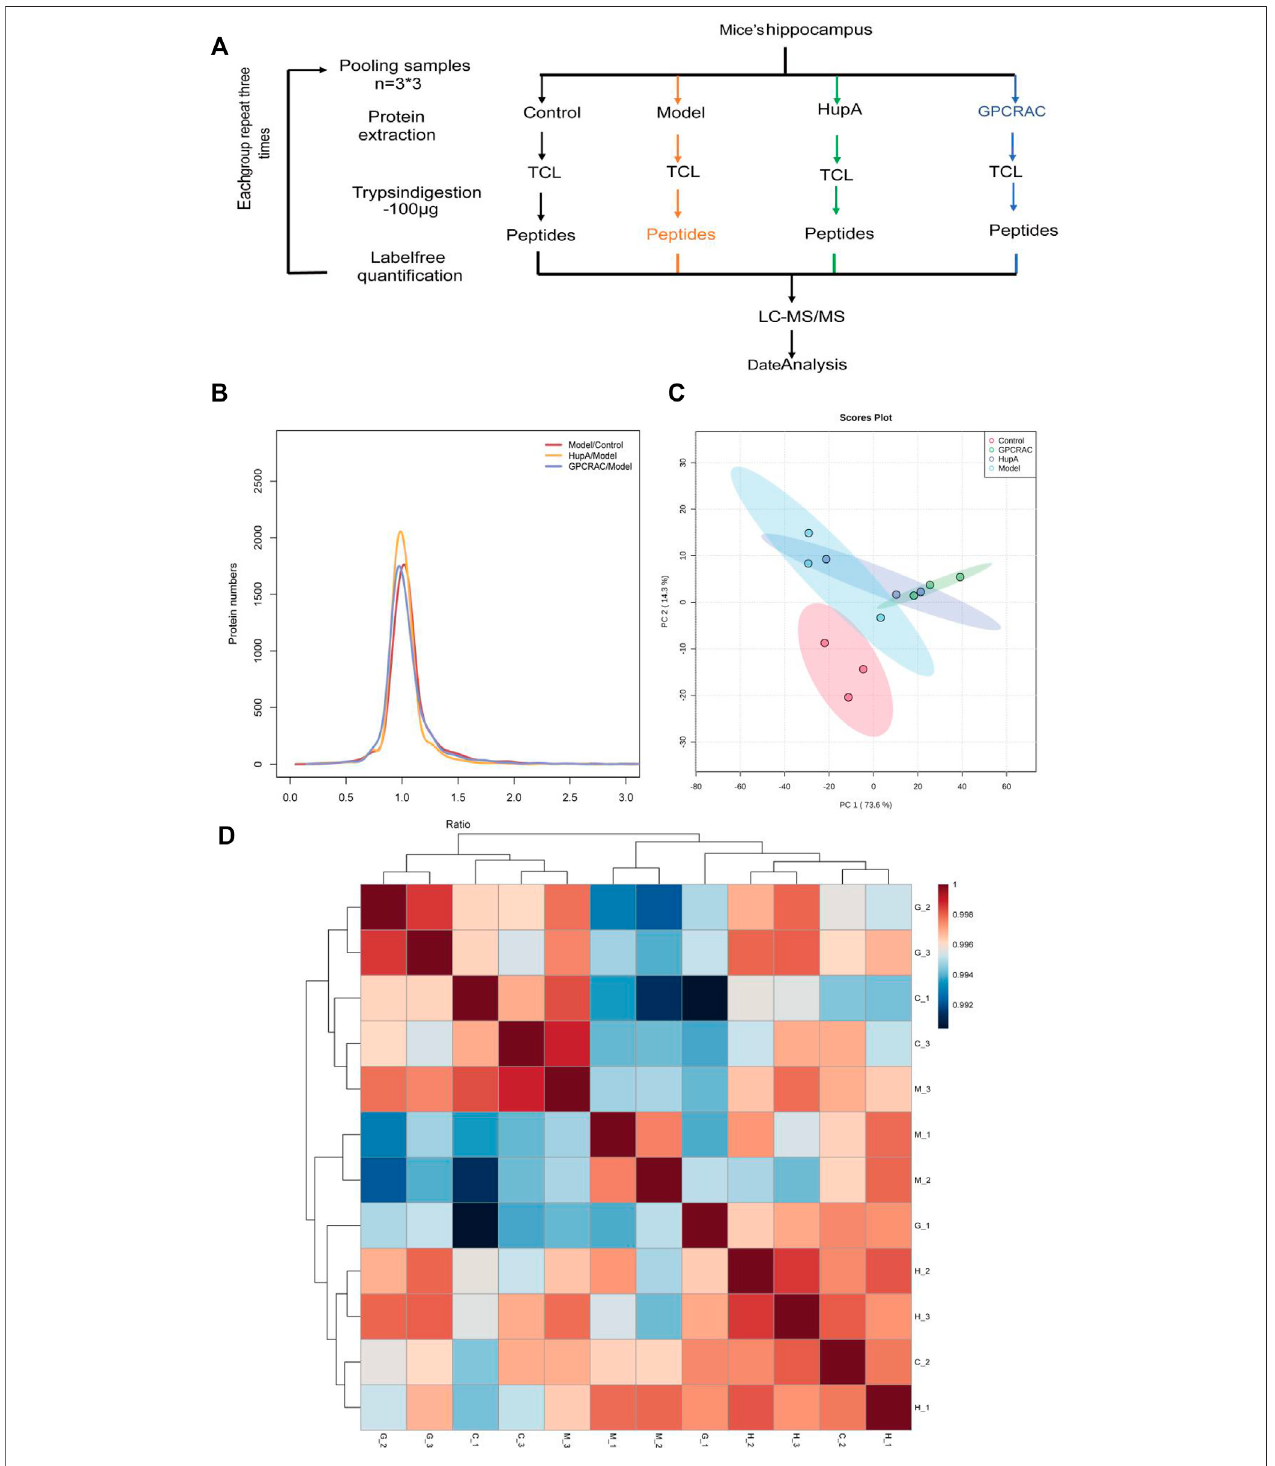
FIGURE 4 | Quality assessment of the proteomic data. Graphical illustration of the work fl ow used for our LC-MS/MS-based proteomic analysis (A) ; Log2ratio distribution of all differentially expression proteins detected in each group of three replicate samples, as determined by ANOVA based on FDR < 0.05 (B) ; The PCA analysis of hippocampal proteomes obtained from scopolamine-induced AD mice (C) . Sample correlation heat map between different group (D).